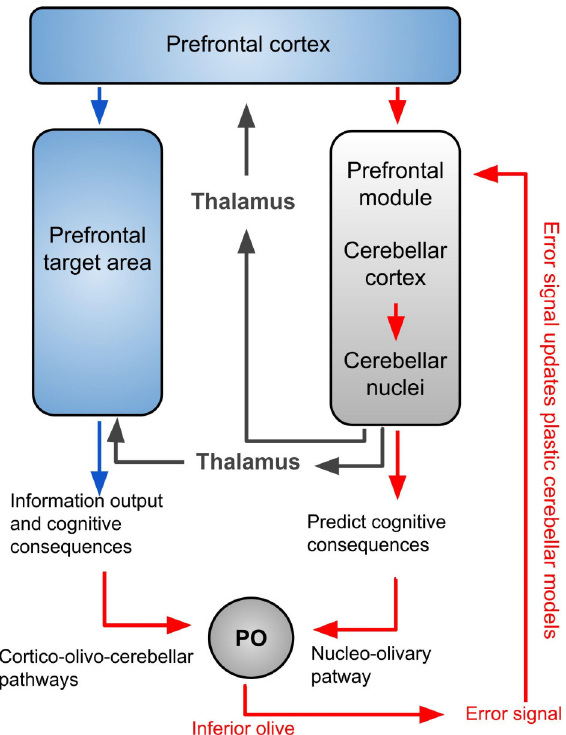
Figure 4. Cerebellar model of processing in prefrontal targets, extension of the forward cerebellar cortical model published by Ramnani (2006). This model is involved in the simulation of information processing in which the cerebellar cortical circuit simulates the processing of information in the targets of all areas that project to the cerebellum through the cortico-ponto-cerebellar system. The information arising in the prefrontal cortex is copied to the cerebellum. In this scheme, cerebellar forward models mimic the input–output relationships of prefrontal targets. Forward models might therefore be able to mimic information processing that is intrinsic to the prefrontal cortex.